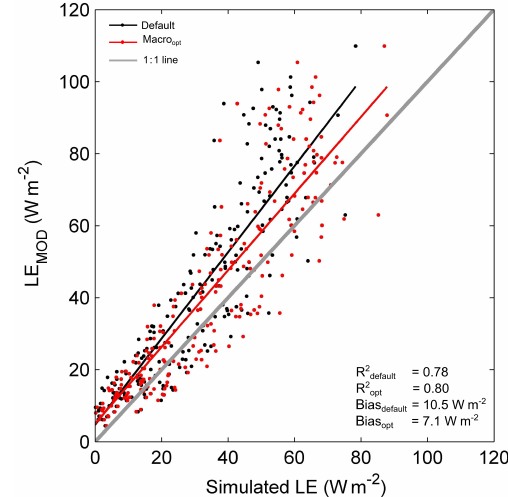
Figure 7. Catchment average 8-day composites of MODIS esti- mated LE (LE MOD ) against simulated LE from the default and macro configurations (LE default and LE macro , respectively) along with the linear models fitted for LE default (black line) and LE macro (red line). The 1:1 line is shown in grey, which represents the per- fect fit between LE MOD and simulated